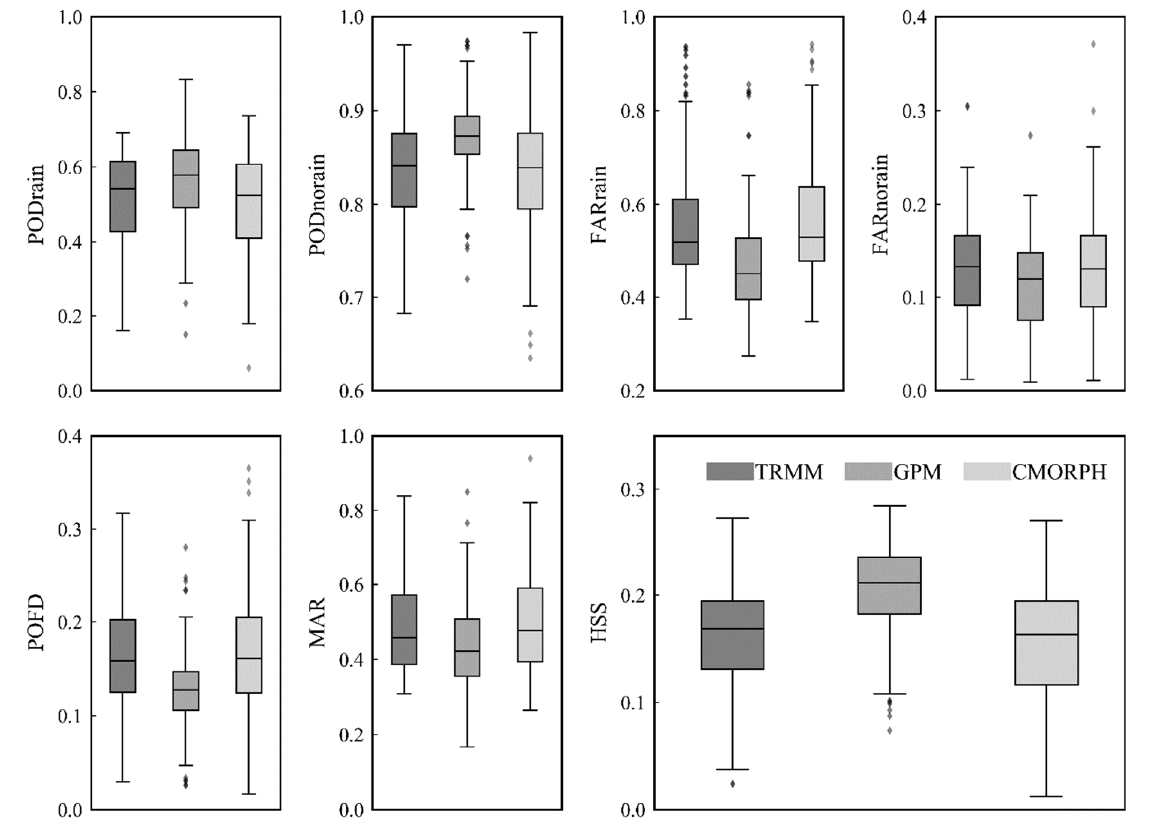
Figure 8. Box plots of each detection capability index for three remote sensing precipitation products. The points outside the box boundary indicate outliers.